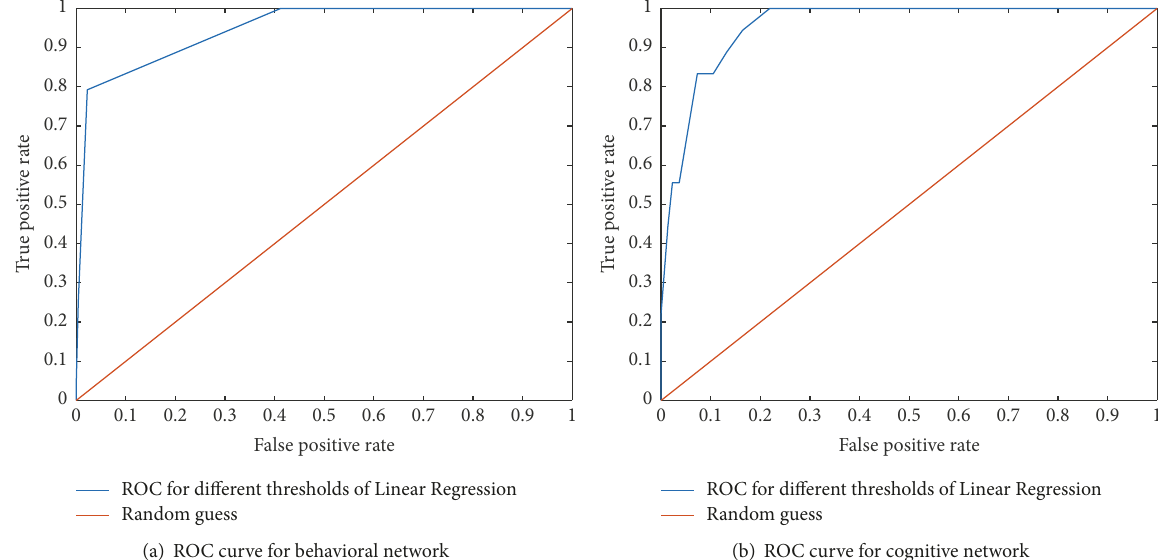
ROC for different thresholds of Linear Regression Random (a) ROC curve for behavioral network (b) ROC curve for cognitive network Figure 4: The plot of the ROC curve for prediction of edge formation in both the behavioral and cognitive networks for different thresholds of edge weight in the second semester (the curves for other semesters are similar). The curve shows that the models fit the data well, but that the higher the recall, the higher the false positive rate. The prediction in behavioral network performs a little better than it does in the cognitive network.